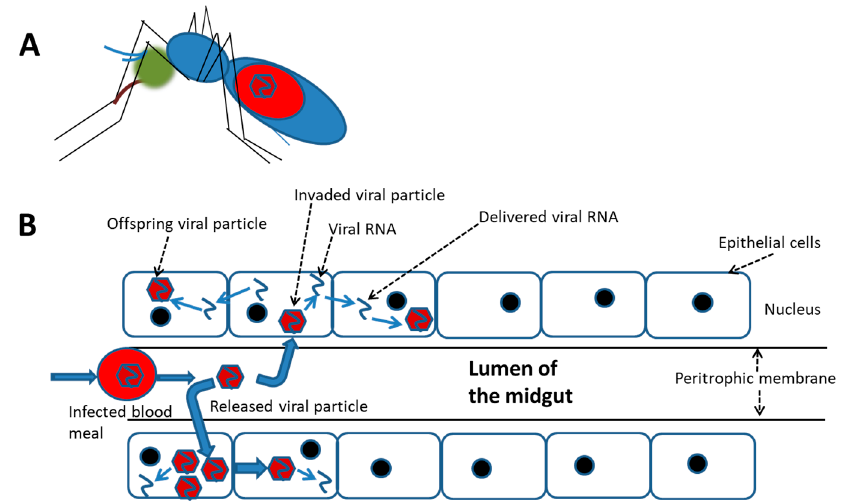
Figure 1. A schematic cell-to-cell spreading model of the dengue virus ingested in accompany with the blood meal in the mosquito midgut. ( A ) The virus infection in the female mosquito vector begins with a blood meal from viremia of a patient. ( B ) Simulation for cell-to-cell spread of the virus in the midgut of an engorged female. At the beginning, the ingested virus sporadically infects epithelial cells of the midgut. It is followed by extensively spread via cell-to-cell transmission before the virus disseminates to other organs.